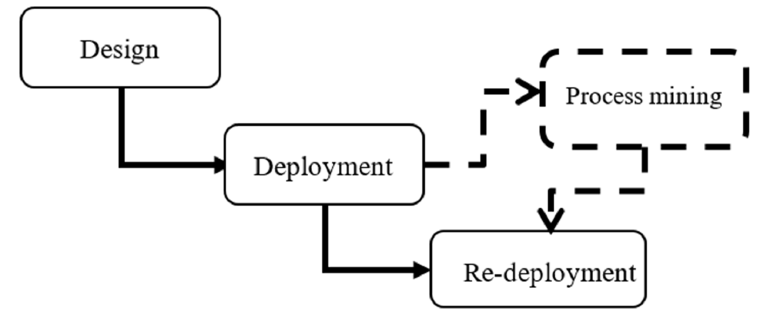
Figure 3. Proposed solution process using process mining using confusion matrix of transitions in order to change sensors’ position or angle.